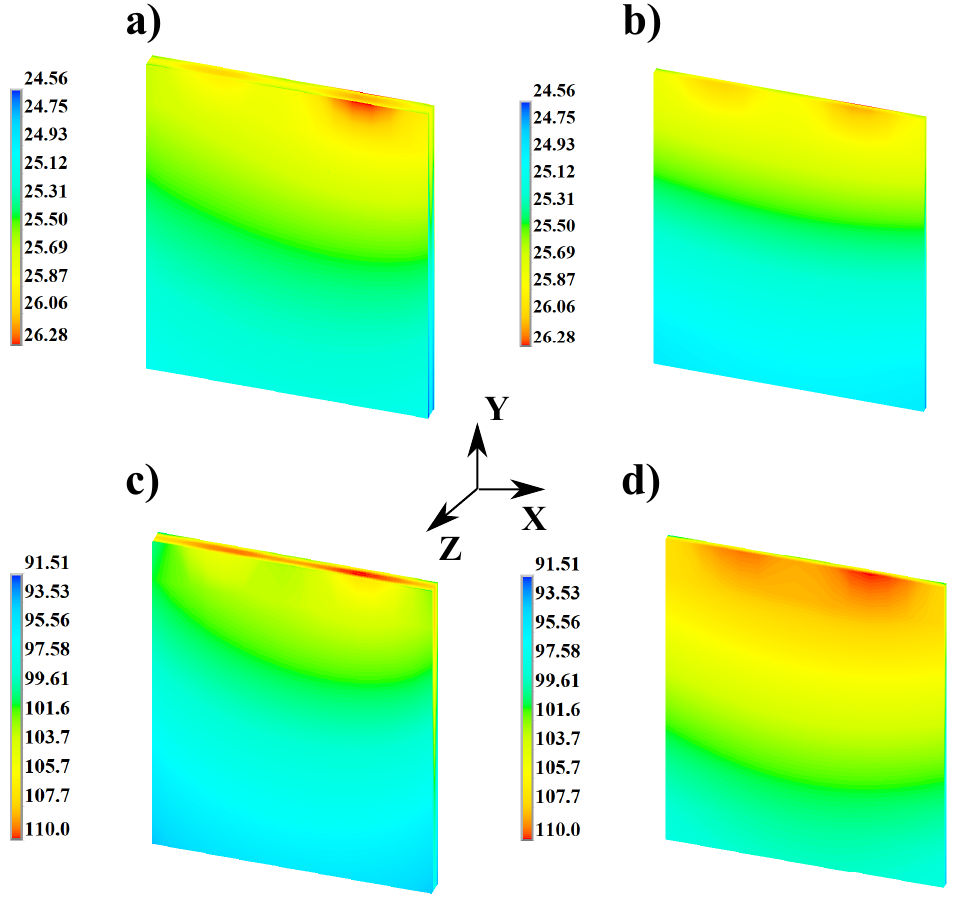
Figure 8. Current density [ A/m 2 ] on current collectors of different layers at SOC = 50%: ( a ) at 1C in layer No.1; ( b ) at 1C in layer No.21; ( c ) at 4C in layer No.1; ( d ) at 4C in layer